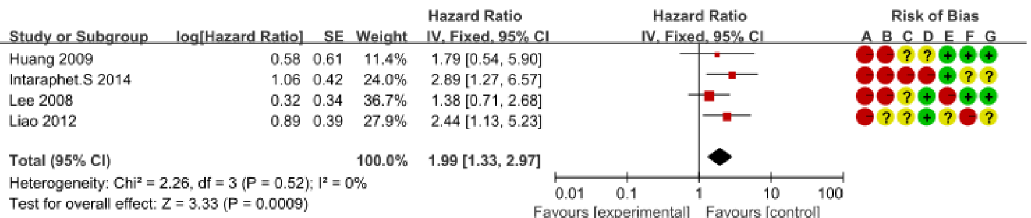
Fig 8. Forest plot of depth of stromal invasion ( > 2/3/ (cid:20) 1/3/) and overall survival of small cell carcinoma of the cervix patients. SE: standard error; CI: confidence interval.